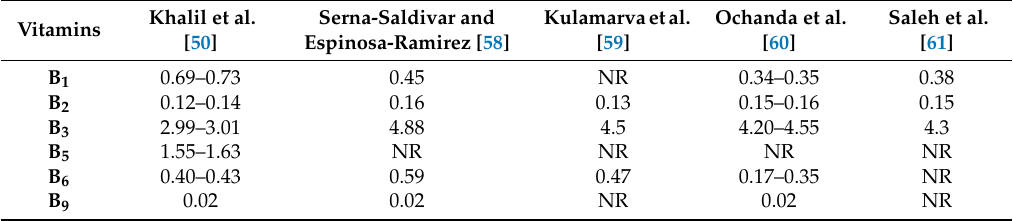
Table 4. Vitamin composition (mg / 100 g) of